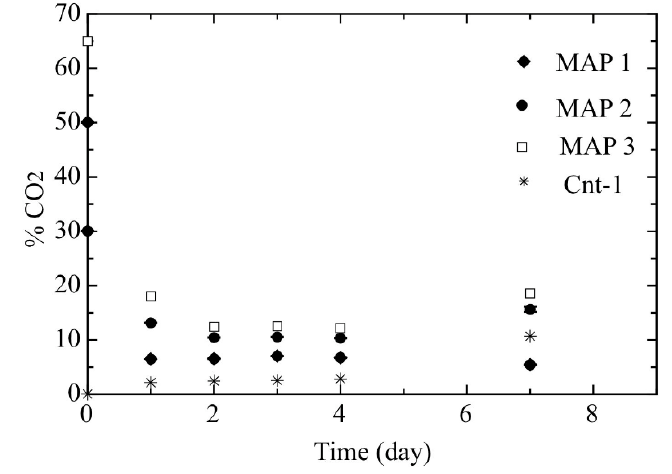
Figure 1. Carbon dioxide concentration in burrata samples packaged in air and under MAP.